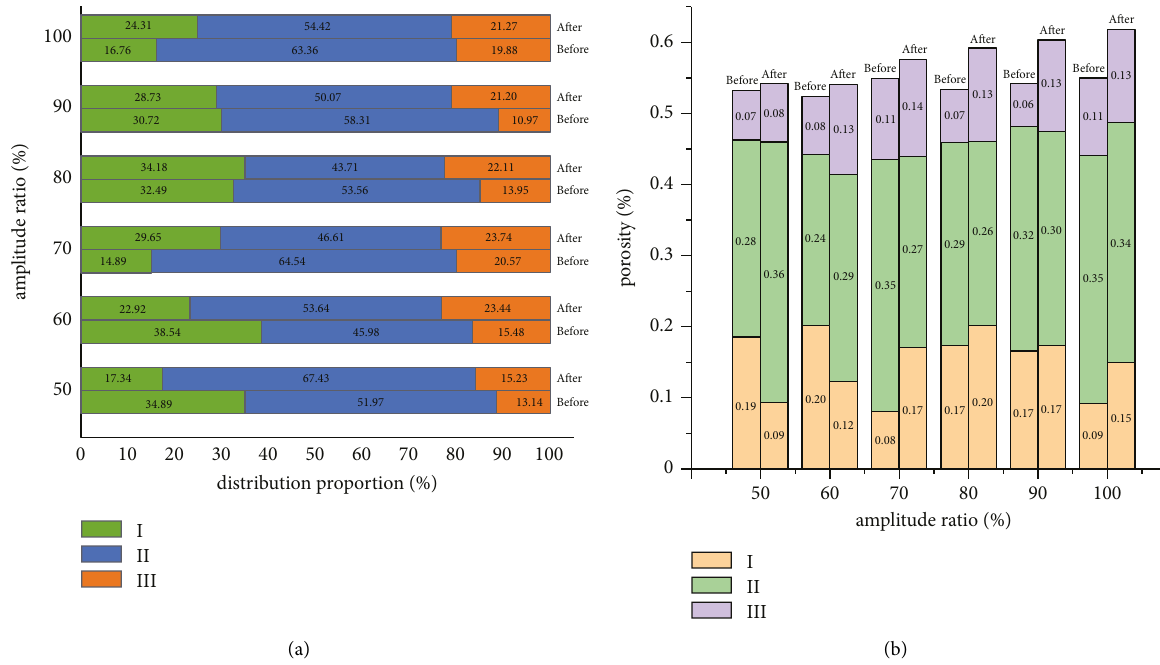
Figure 5: Percentage and value of porosity of three types of pores: (a) the percentage of pores, (b) porosity of pores.